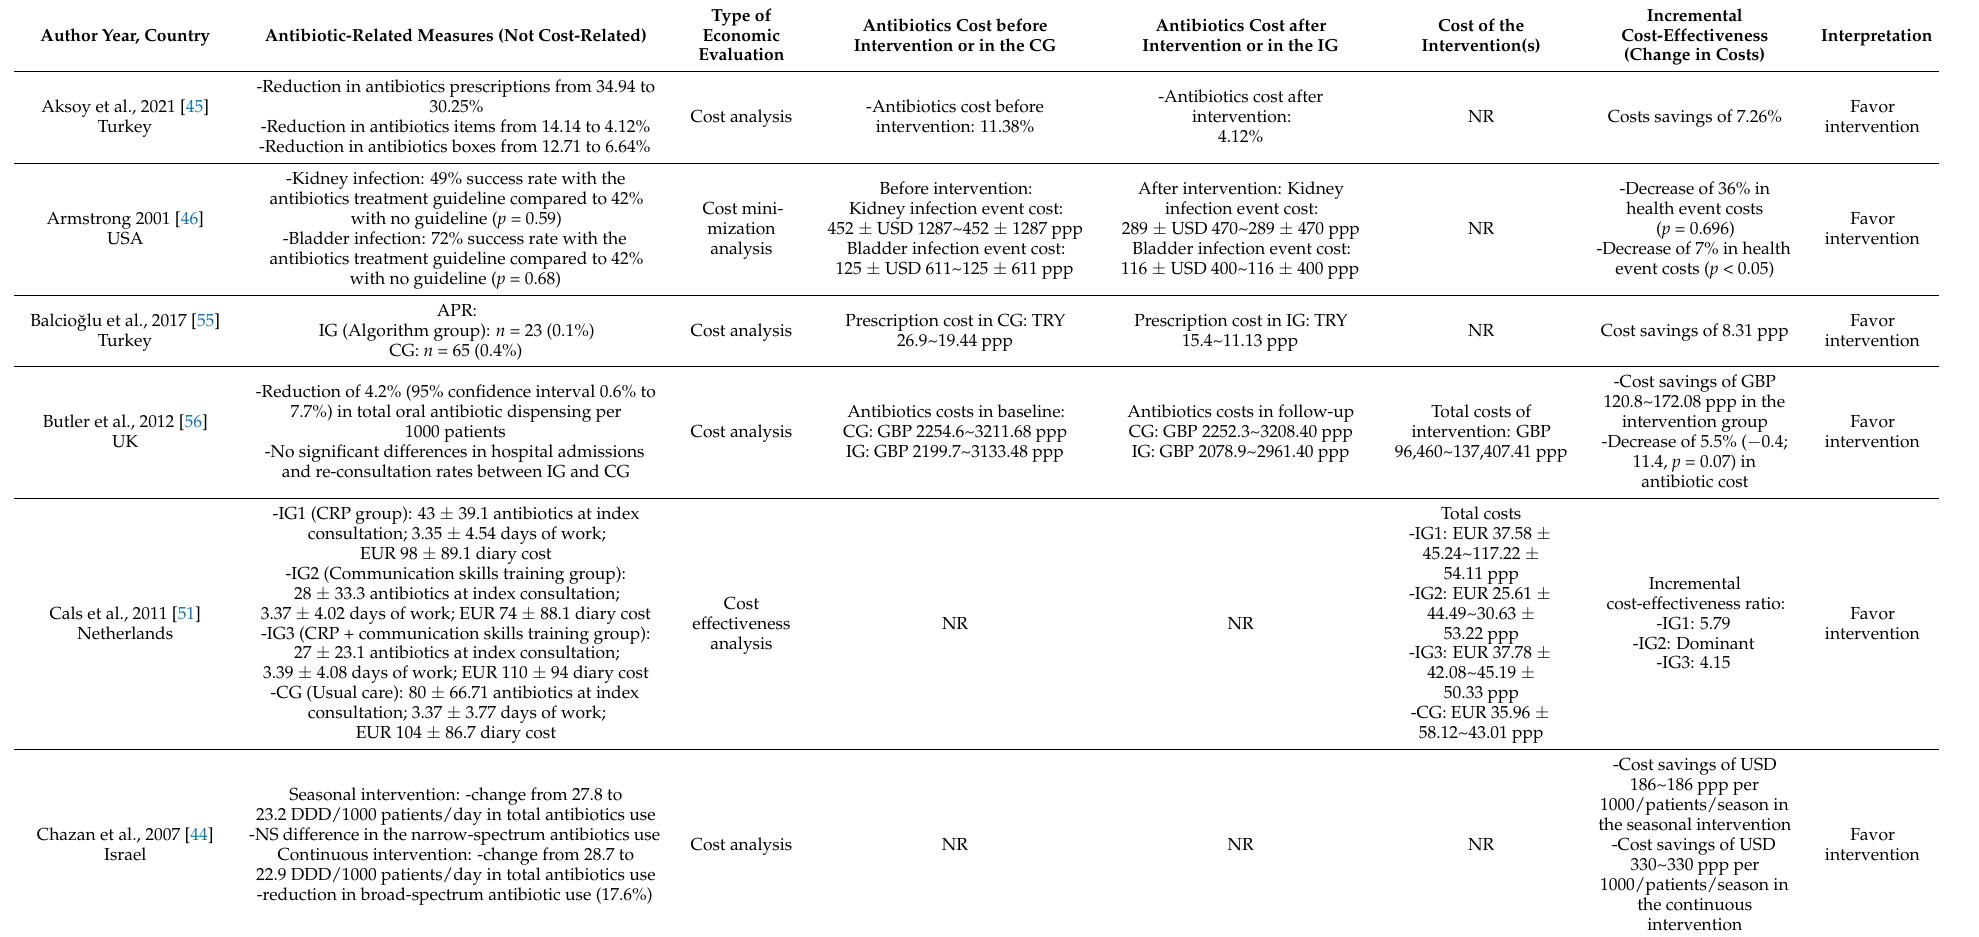
Table 1. Summary on the economic effects of the educational